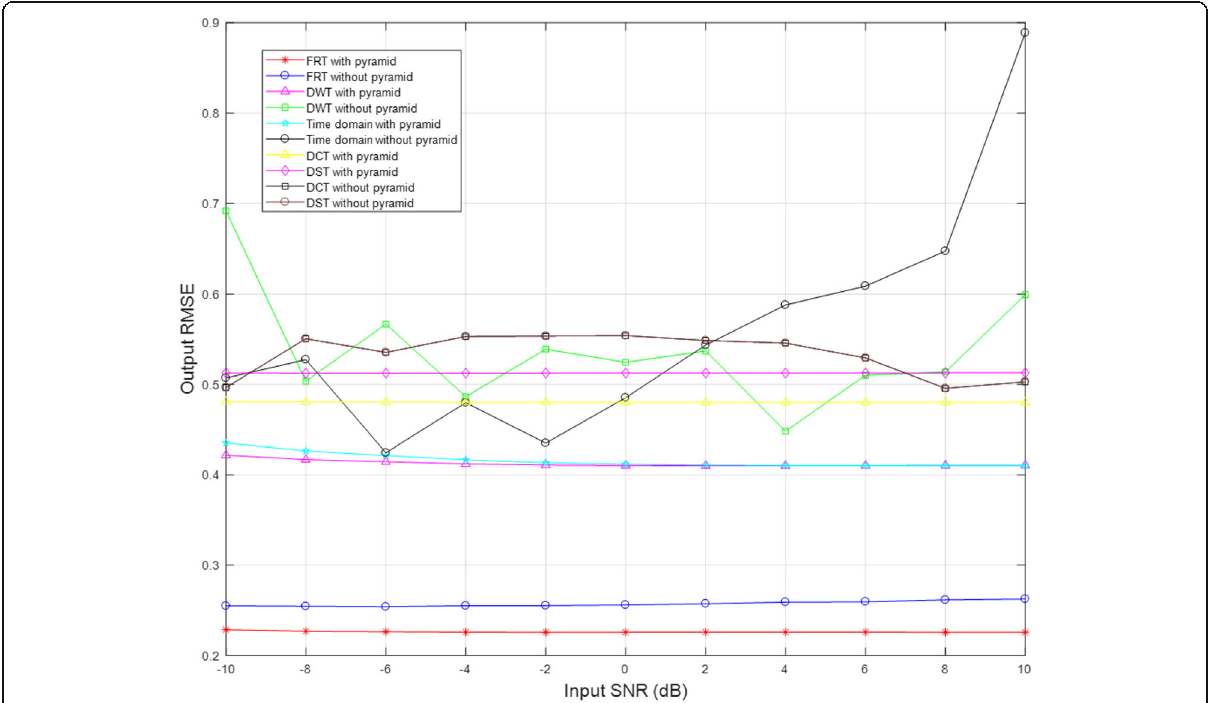
Fig. 15 Output RMSE vs. input SNR for Cameraman image overall separation performances